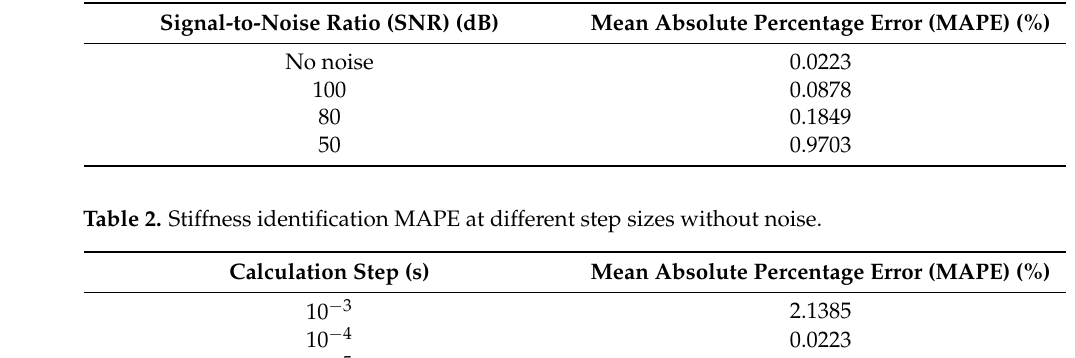
Table 1. Stiffness identification MAPE at different SNRs.